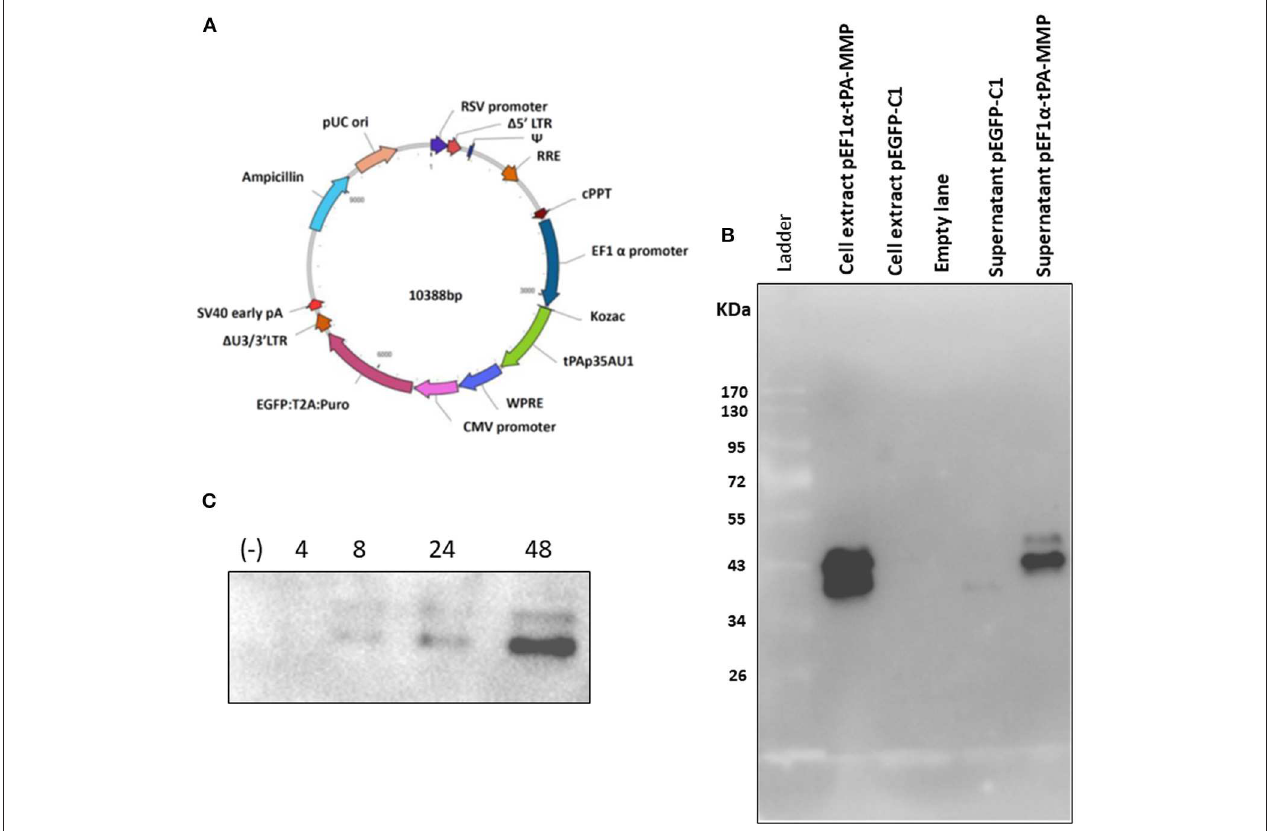
FIGURE 2 | (A) Diagram of a third-generation lentiviral transfer vector delivering tPA-MMP ORF (tPAp35AU1, green) expression cassette and GFP/Puromycin reporter gene/selectable marker (EGFP:T2A:Puro, purple) expression cassette. Different genetic elements depicted within the construct from nucleotide position 0 are: RSV promoter (blue violet); 1 5 ′ LTR (brown); 9 (medium blue); RRE (chocolate); cPPT (brown); EF1 α (navy); WPRE (royal blue); CMV promoter (orchid); 1 U3/3’ LTR (sienna); Sv40 early pA (red); Ampicillin (turquoise); pUC ori (dark salmon). (B) Western immunoblot of pEF1 α -tPA-MMP and pEGFP-C1 transfected HEK 293T cell extracts and supernatant. Lanes with cell extract were loaded with 20 µ g of total protein, whereas the lanes with supernatant were loaded with 20 µ l of serum-free medium incubated for 48h with transfected cells. Cells transfected with pEGFPC-1 served as negative controls ( Mock ). (C) Western immunoblot of pEF1a-tPA-MMP-CMV-EGFP:T2A:Puro-transduced and Puromicin-selected HKB-11 cells, supernatant collected at 4, 8, 24, and 48 h incubation. In each lane, 15 µ l of conditioned serum-free medium was loaded. The negative control (–) was established with a similar lentiviral vector delivering only GFP (pEF1 α